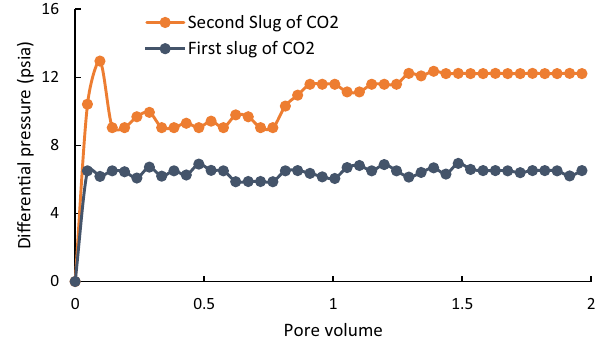
2 slug before and after blended